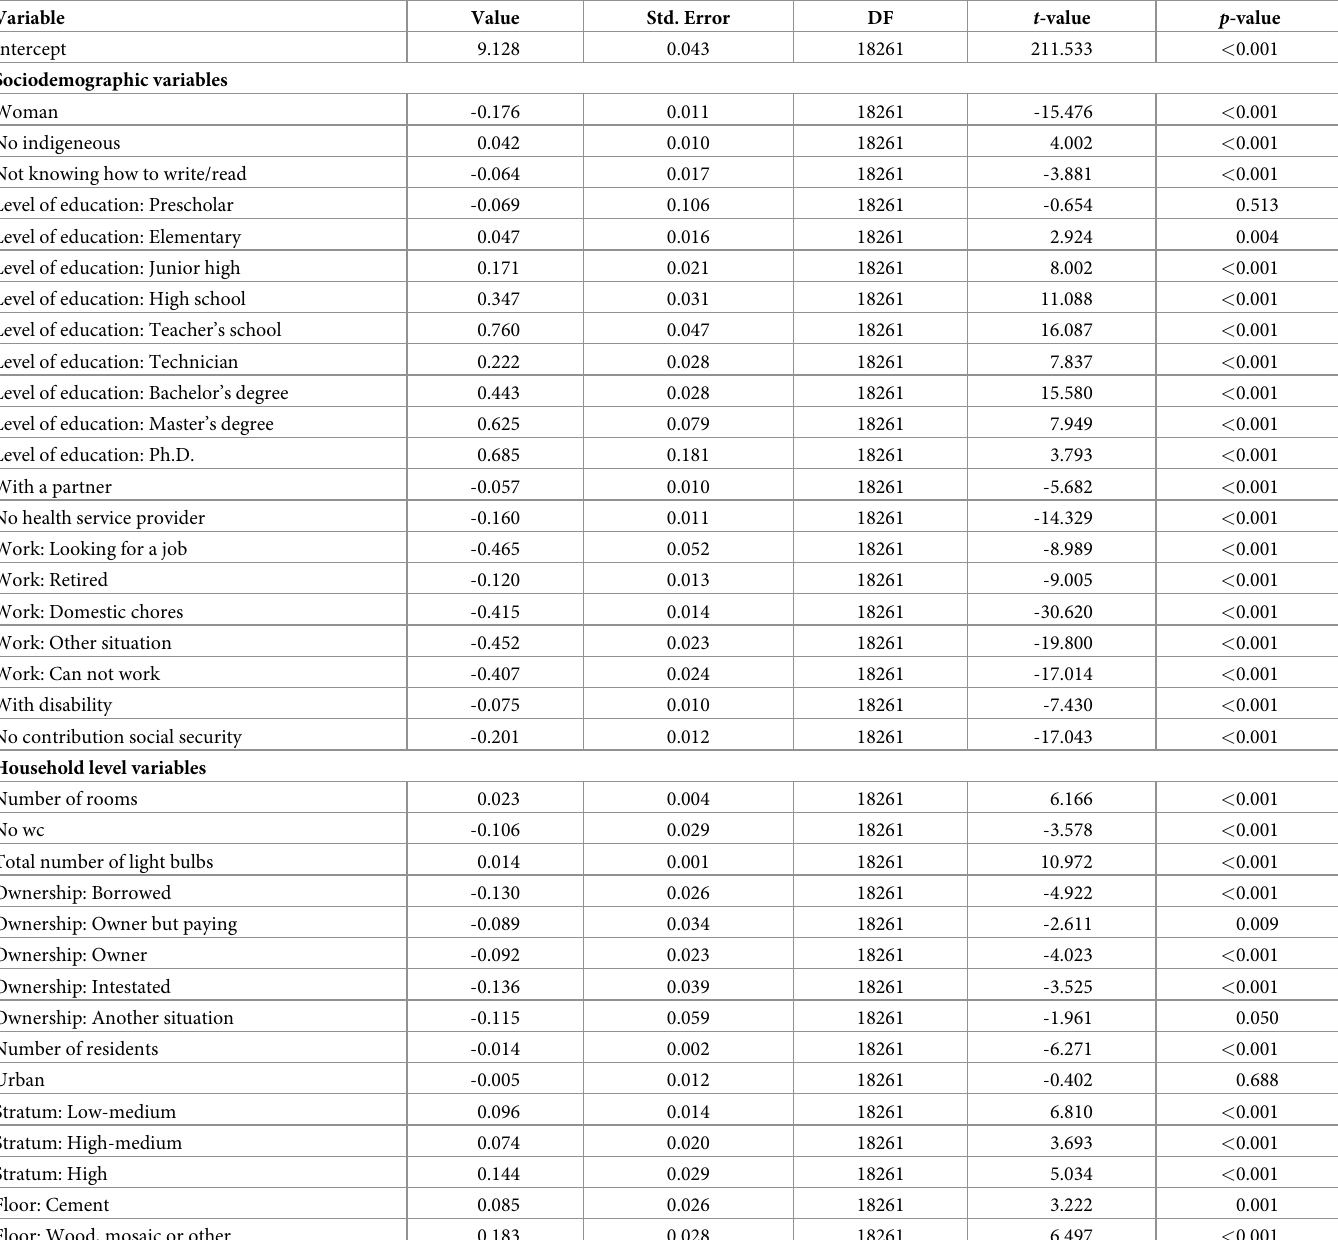
Table 3. Parameter estimations for the RIM associated with income in a logarithmic scale for elderly people data in 2016.